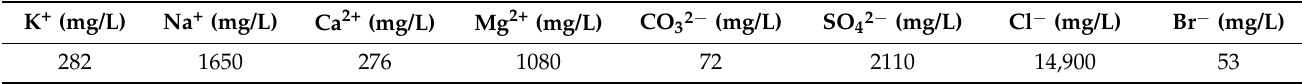
Table 2. Chemical composition of seawater.